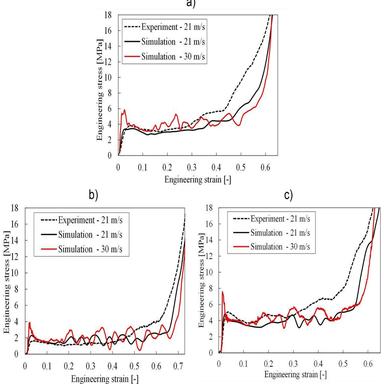
Experimental and computational nominal stress strain relationships at 21 m/s and 30 m/s impact for a) ACS_V1, b) ACS_V2_RD6, and c) ACS_V2_RD9.